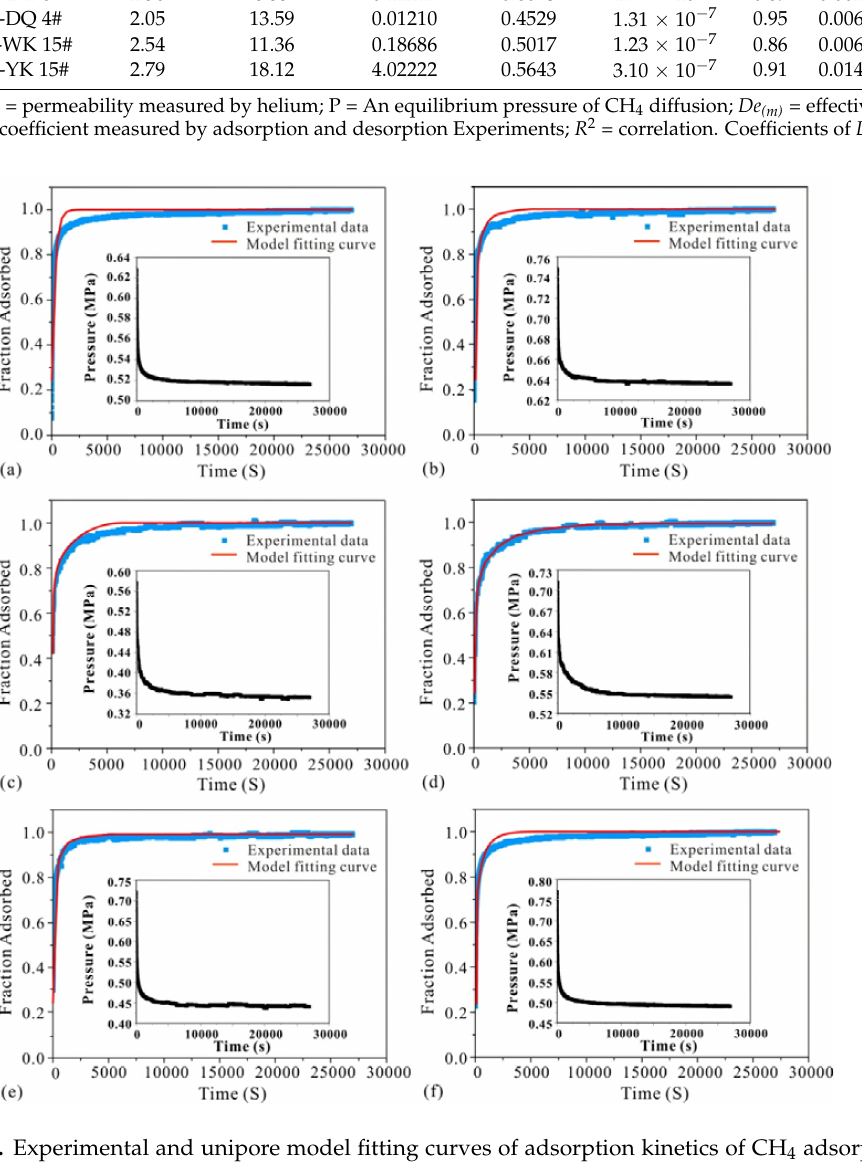
Figure 3. Experimental and unipore model fitting curves of adsorption kinetics of CH 4 adsorption on various coals. (( a ): HDG 6#; ( b ): HYC 4#; ( c ): LL-HJG 5#; ( d ): LL-DP 10#; ( e ): GJ-DQ 4#; ( f ): YQ-WK